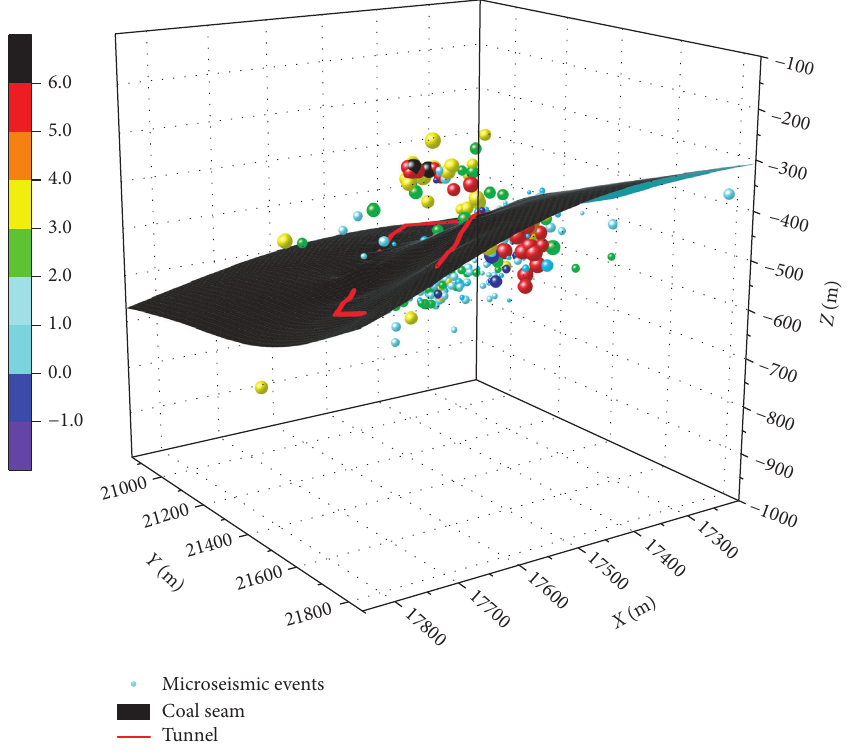
Figure 9: Spatial distribution map of microseismic events before